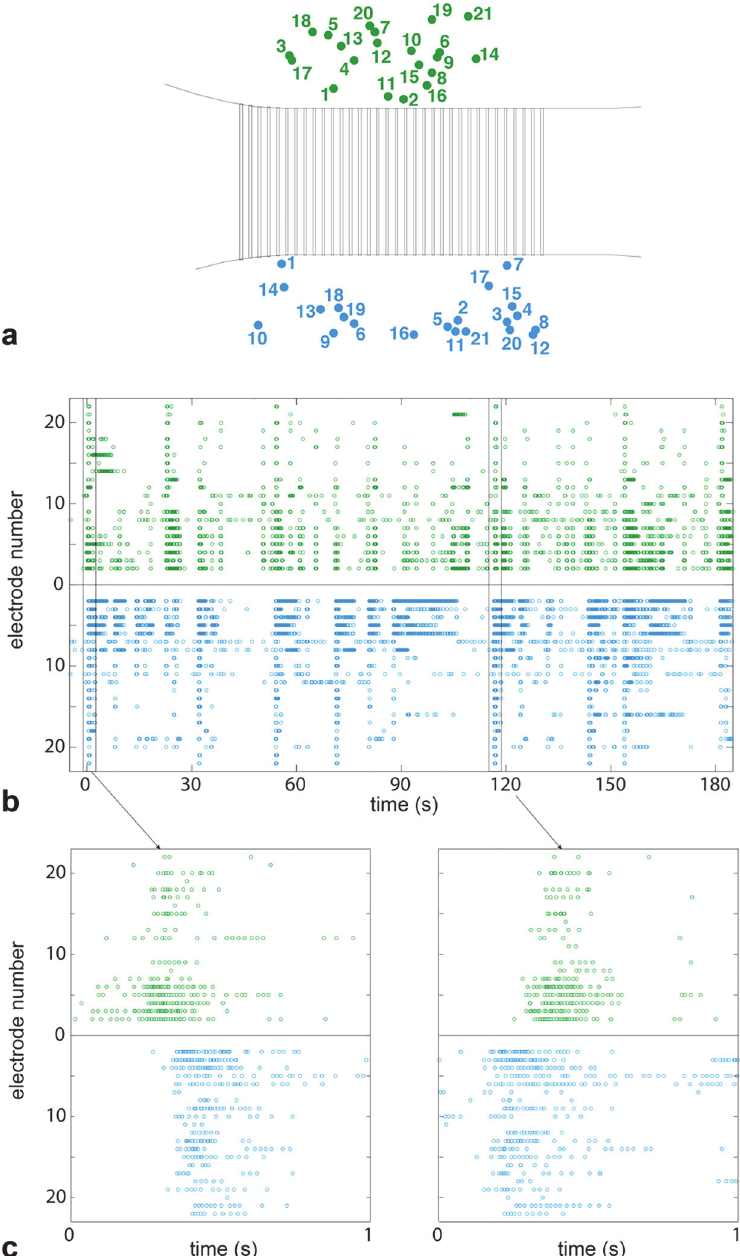
Fig 4. Raster plot showing the two culture chambers were functionally connected. The two culture chambers were connected only by axons in the channels. The top chamber is shown in green, the bottom chamber is in blue. (a) Positions of electrodes on the chip whose signals are displayed in (b) and (c) Inter- and intra-chamber bursts occurred; somas burst together on various time scales with activity propagating from top to bottom (c, left panel) as well as bottom to top (c, right panel). Bursts in the two chambers overlapped 6.2% of the time, while the chance of coincidental overlap was 0.02%, proving that the chambers were